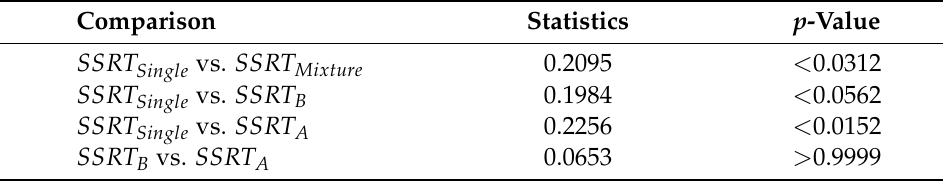
Table 4. Two-sample Kolmogorov–Smirnov test results for the cluster type SSRT distributions in the hypothesis test (17) ( n =